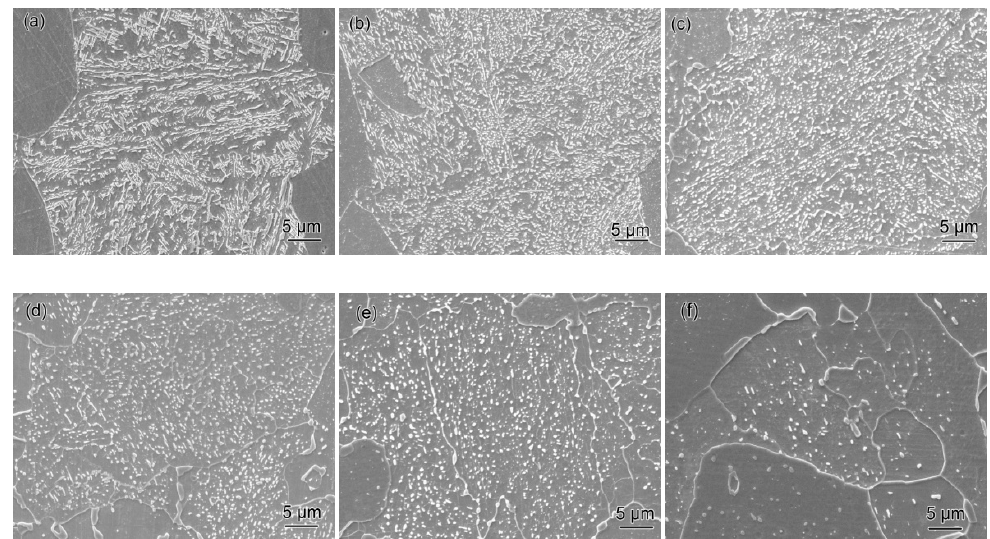
Figure 3. Images of bainite region after tempering at 680 ◦ C for ( a ) 0 h, ( b ) 10 h, ( c ) 50 h, ( d ) 100 h, ( e ) 500 h, and ( f ) 1000